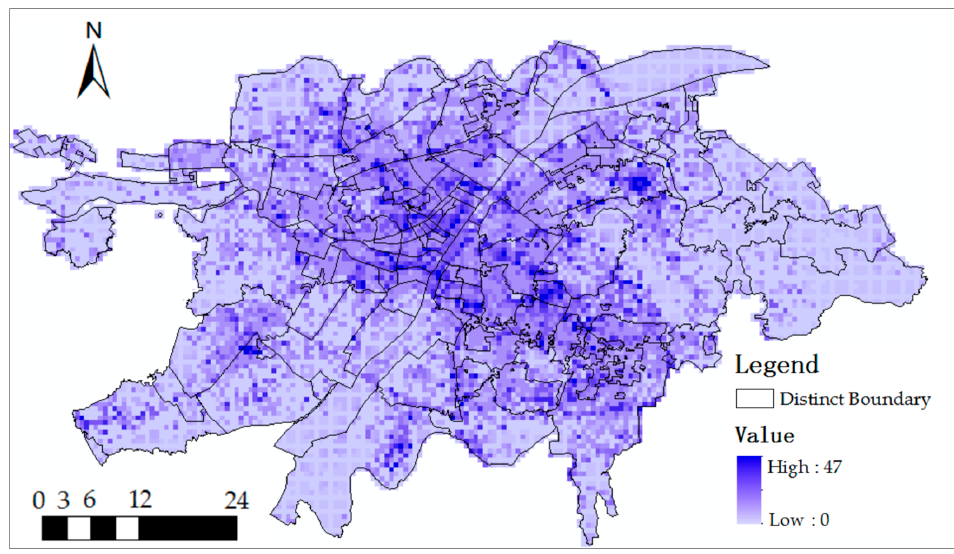
Figure 7. Errors of estimated population mapping results.